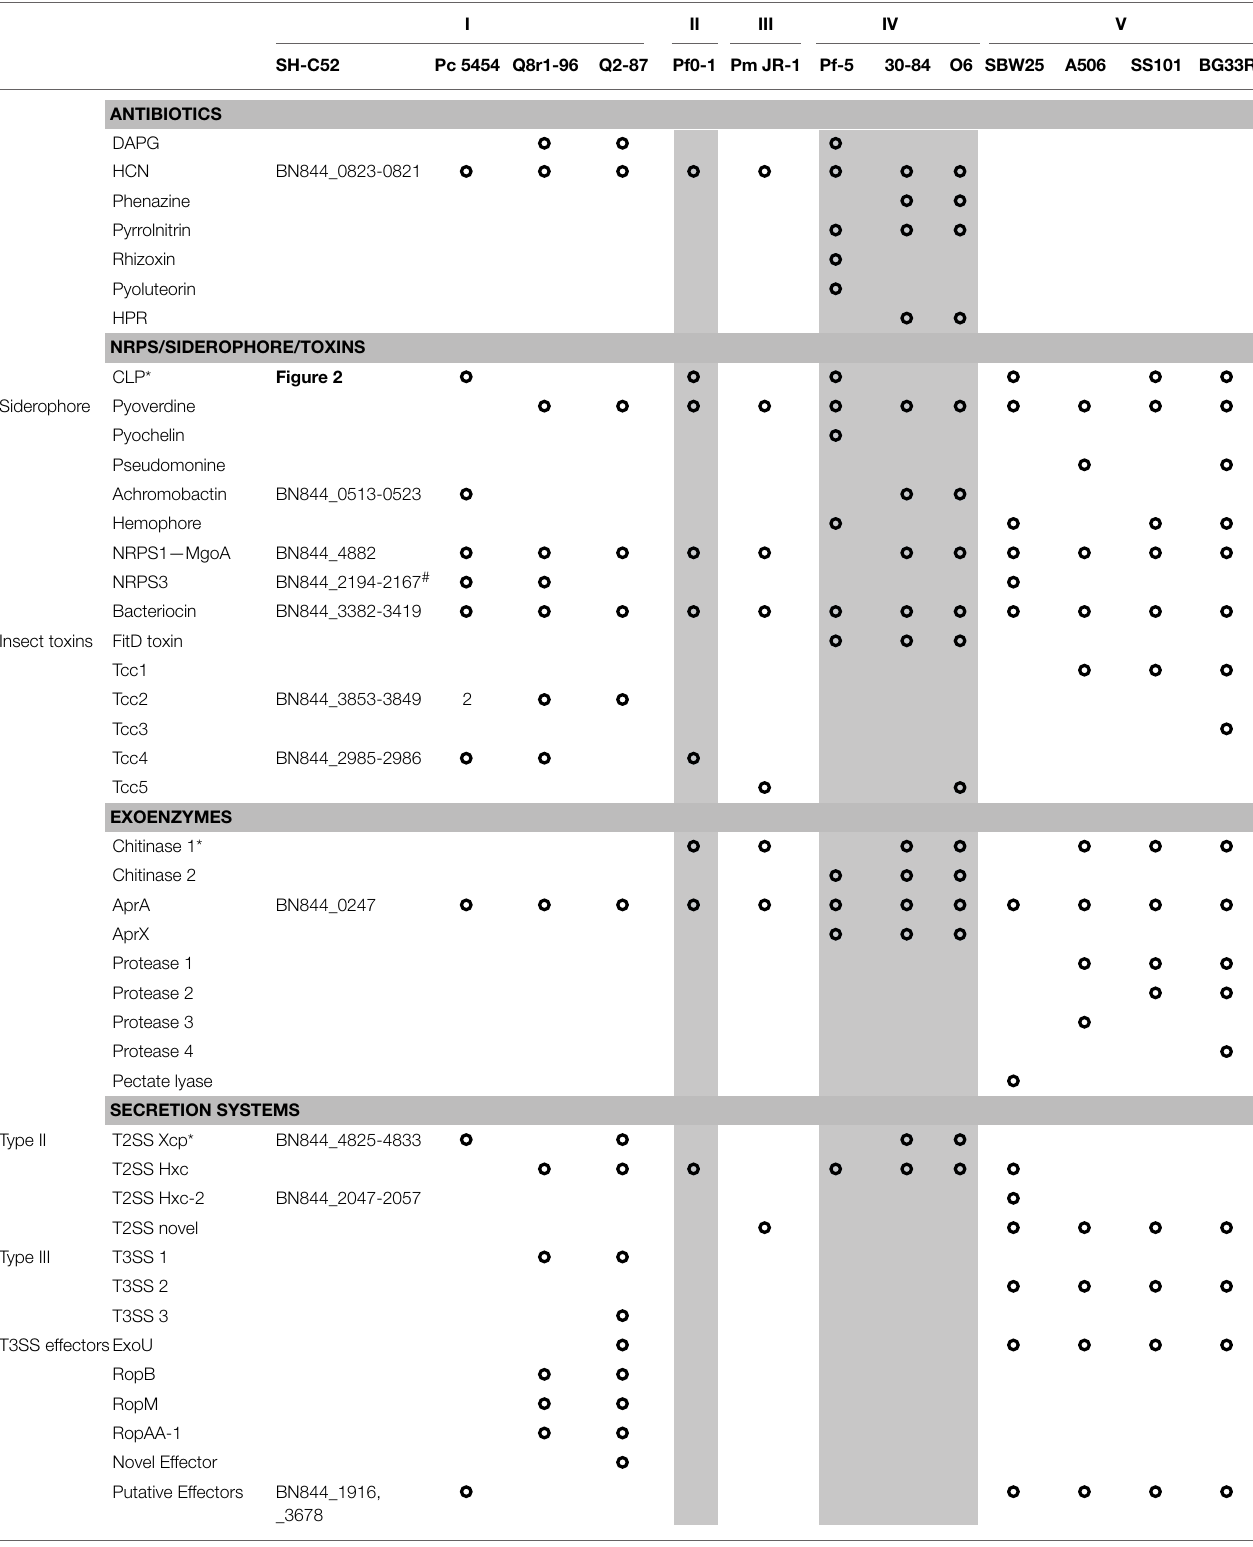
TABLE 3 | Secondary metabolite production and corresponding genes of Pseudomonas sp.